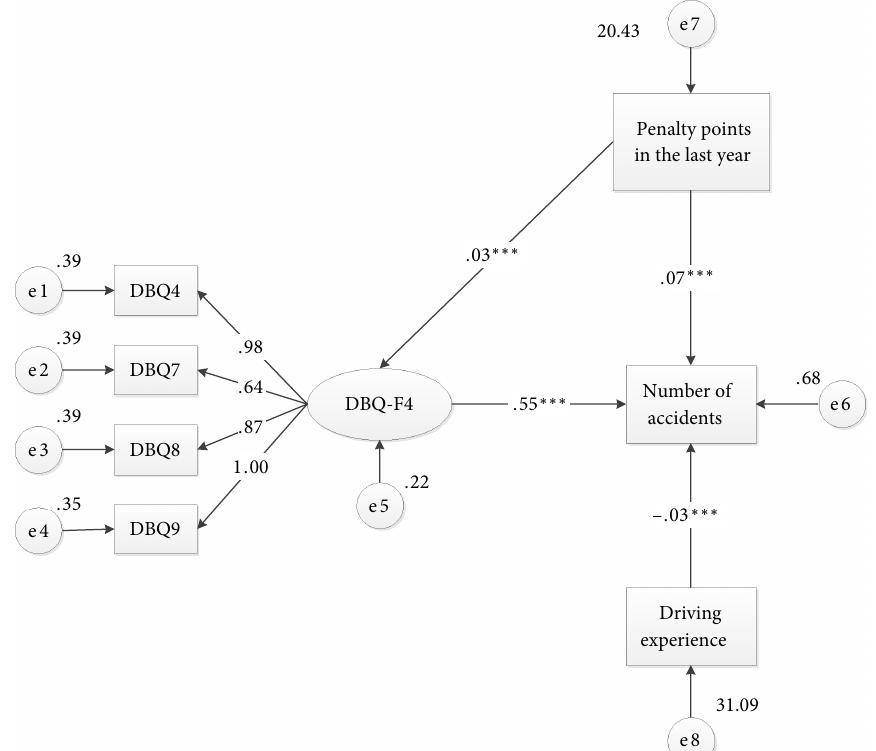
Figure 2: Taxi driver structural equation model path